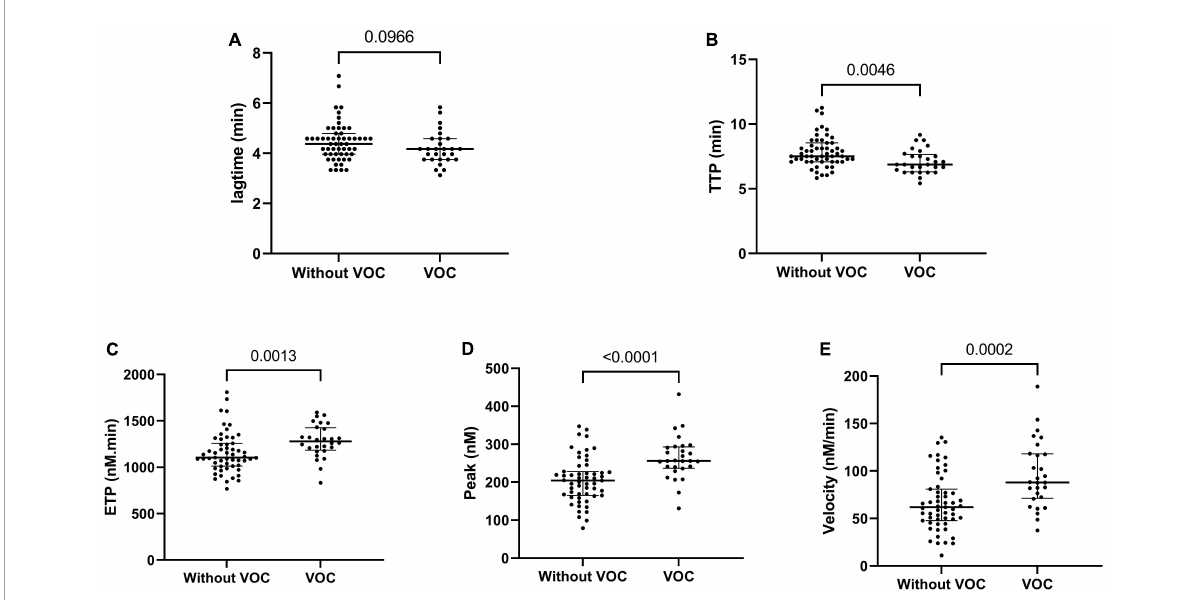
FIGURE2 Thrombin generation parameters associated with VOC development in the year following steady state. Lagtime (A) , time to peak (B) , endogenous thrombin potential (C) , peak thrombin (D) , and velocity (E) . Data are expressed as median [IQR]. P-values comparing SCD in steady state and SCD developing VOC in a year are from Kruskall–Wallis ANOVA with Dunn’s multiple comparisons post-test.